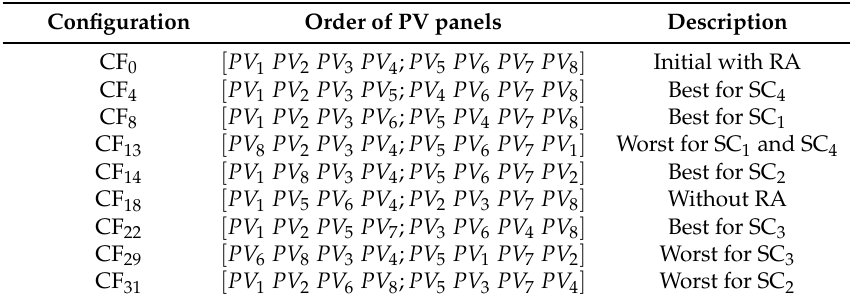
Table 2. Configurations used in the simulations: RA, reconfiguration algorithm; SC, shading